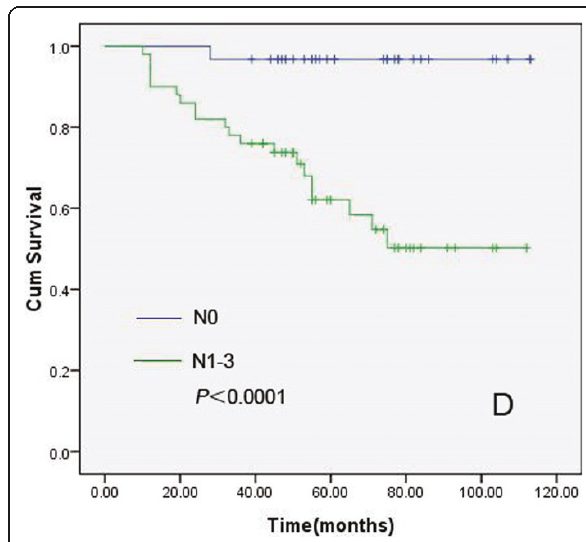
Figure 9 Kaplan-Meier comparison result showed that lymph node status was correlated significantly with IDC patients ’ shortened overall survival . Log rank test P -value (two sided) was listed in the